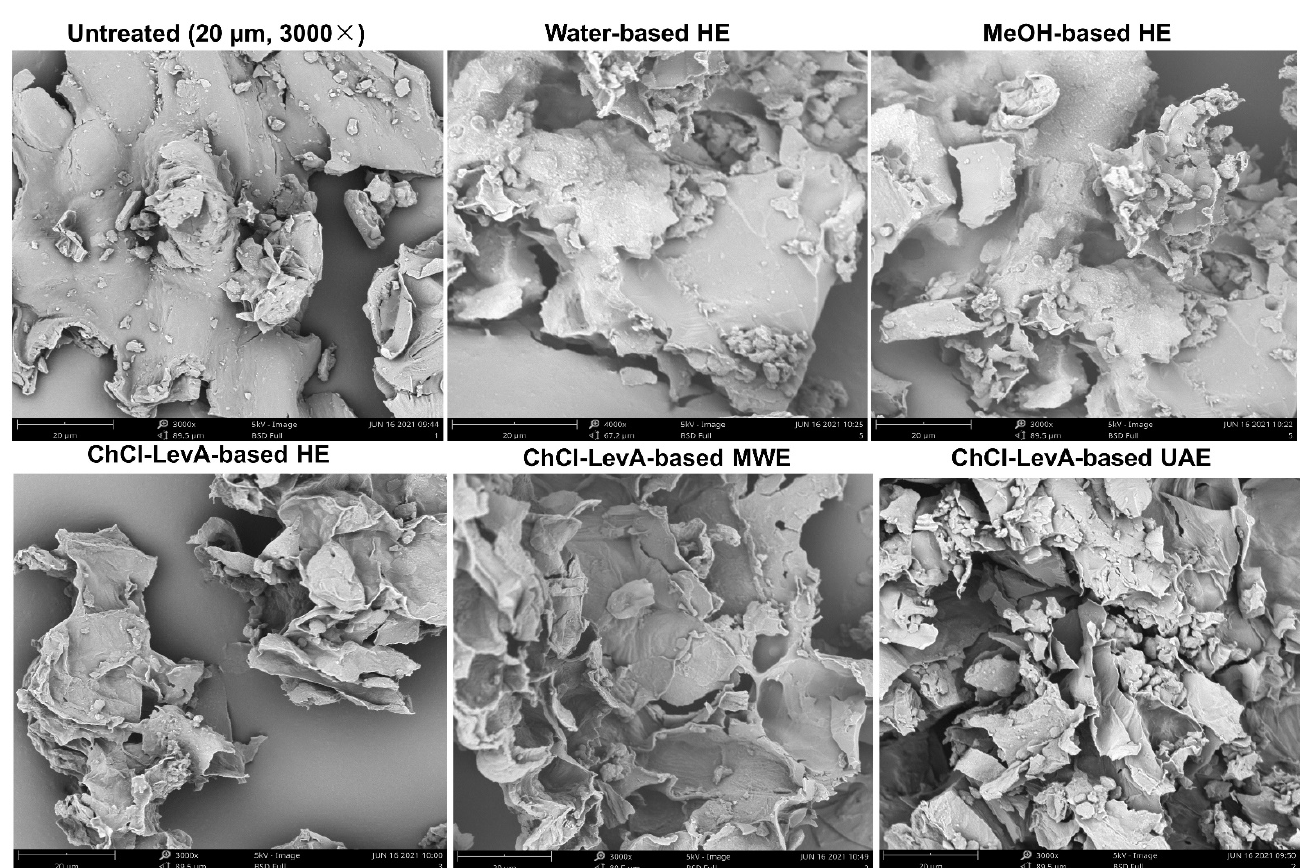
Figure 6. Scanning electron microscopy (SEM) analysis of the raw DLT and the DLT extraction residues after extraction with different methods. Water-based HE, heating extraction with water; MeOH-based HE, heating extraction with MeOH; ChCl-LevA-based HE, heating extraction with ChCl-LevA; ChCl-LevA-based MWE, microwave extraction with ChCl-LevA; ChCl-LevA-based UAE, ultrasonic-assisted extraction with ChCl-LevA.